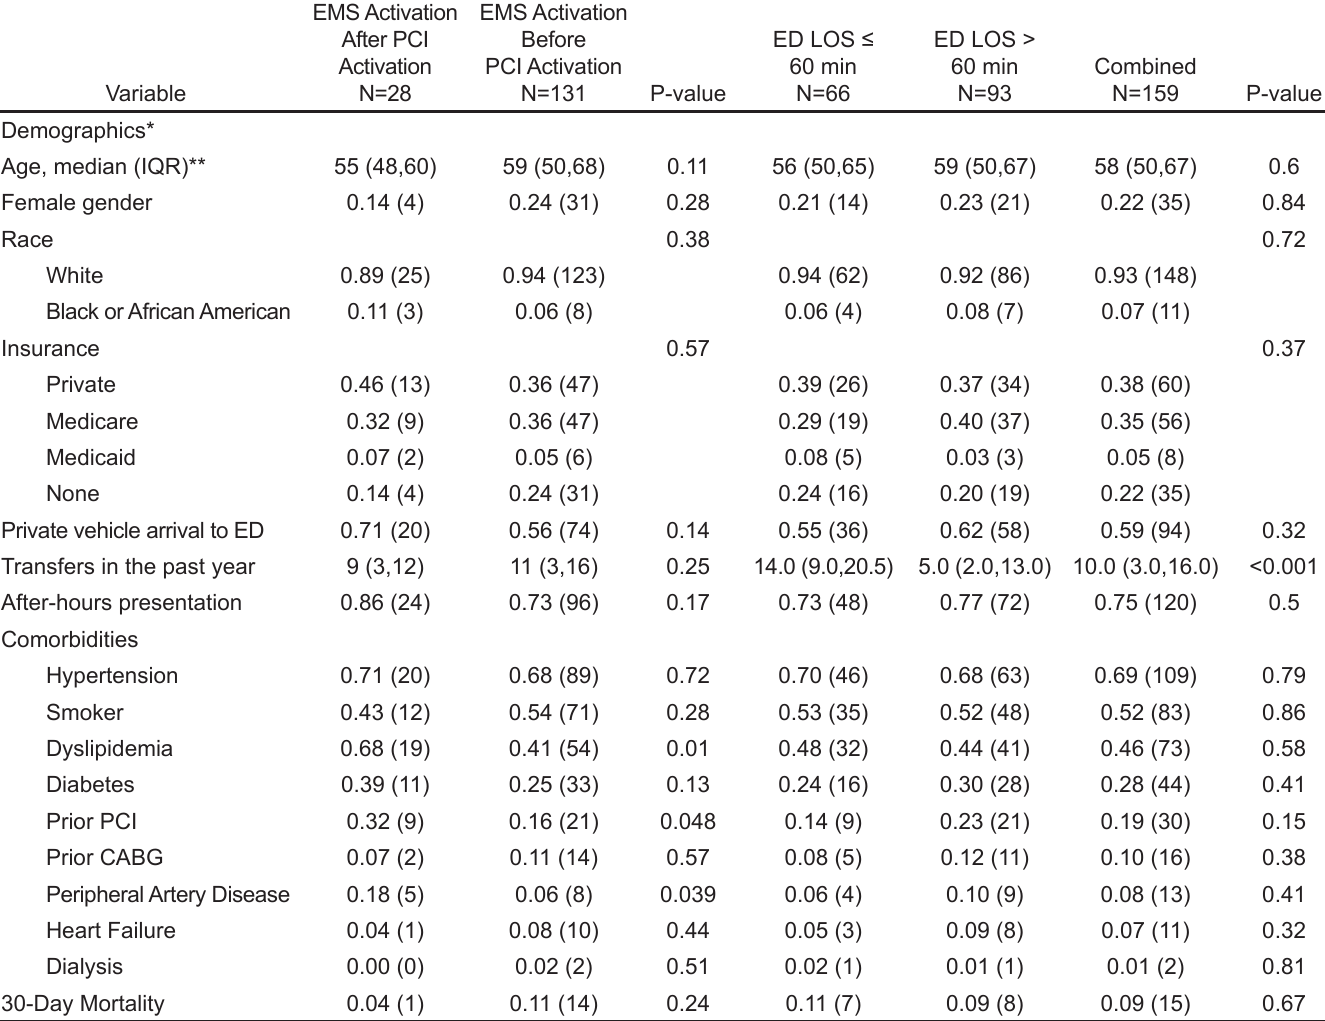
Table 1. Descriptive statistics of percutaneous coronary intervention activation timing relative to emergency medical services activation, and for those transfers above and below 60 minutes by patient